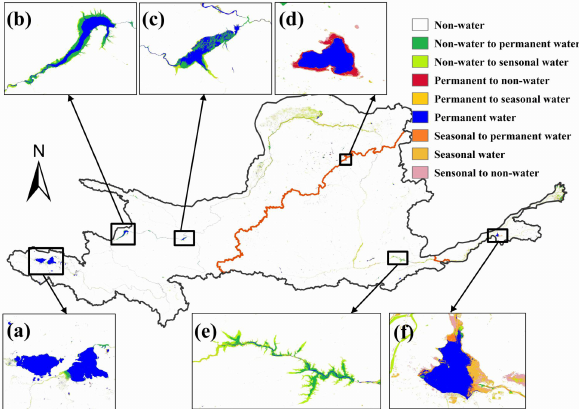
Figure 10. Spatial distribution of conversion of surface water bodies from 2000 to 2020 in the YRB. In order to view the details more obviously, some local typical water bodies are shown with enlargement. (a): Zhaling Lake and Eling Lake; (b): Longyang Reservoir; (c): Liujia Reservoir; (d): Hongjiannao Lake; (e): Xiaolangdi Reservoir; (f): Dongping Lake.